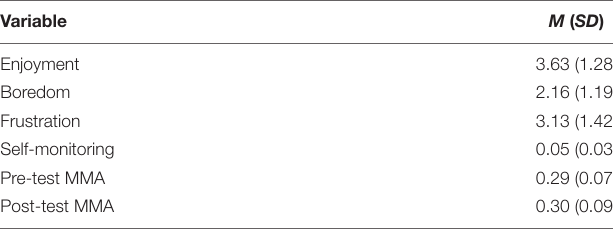
TABLE 2 | Means and standard deviations for aggregated learner-state variables and pre- and post-test MMA. Variable